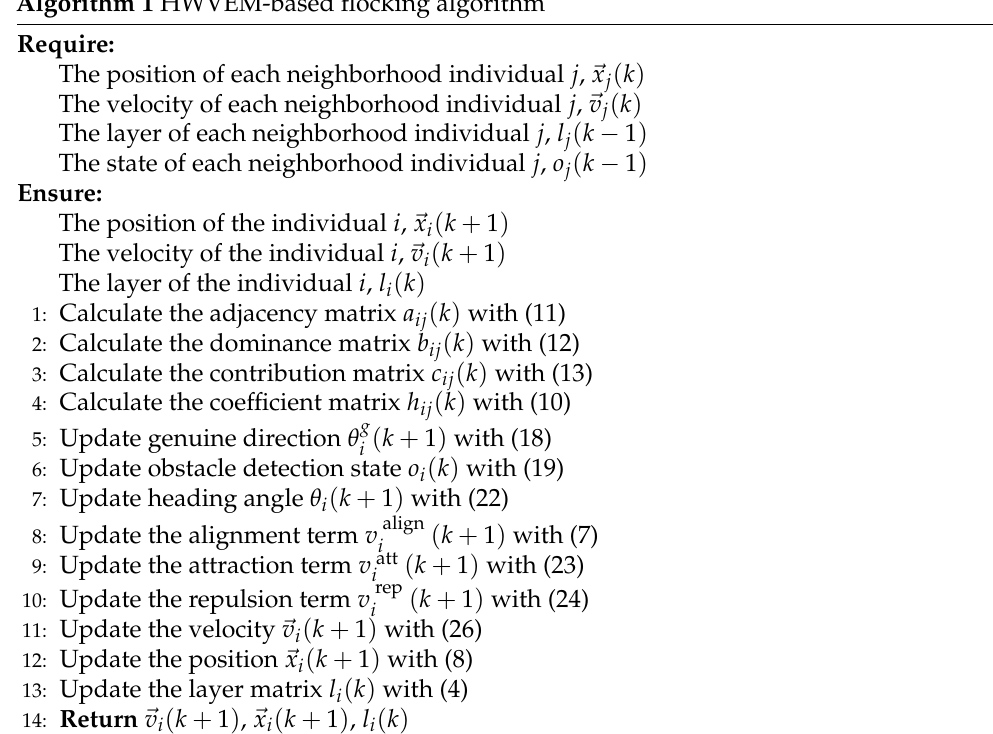
Algorithm 1 HWVEM-based flocking